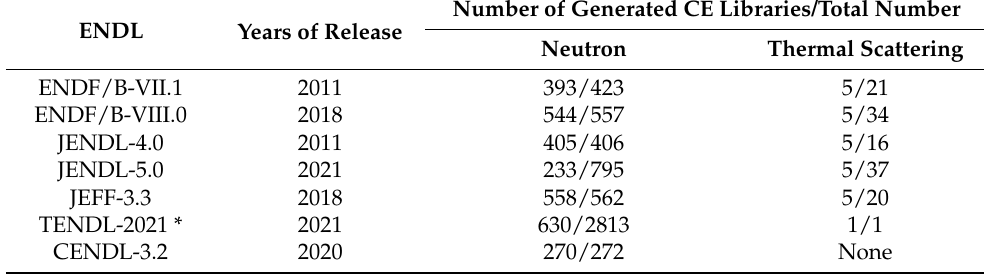
Table 1. A summary of the generated Monte Carlo CE cross section libraries.